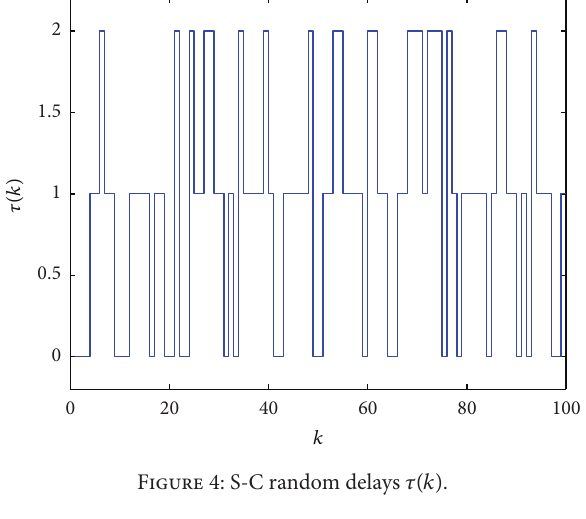
time delays and packet dropouts existing in both the sensor to controller and controller to